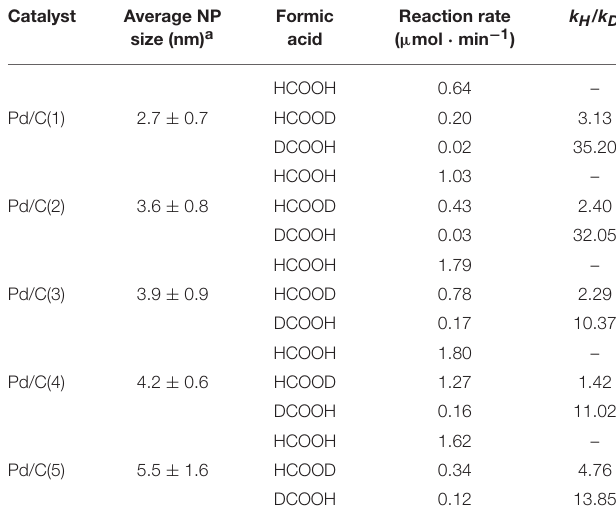
TABLE 2 | KIE in the decomposition of formic